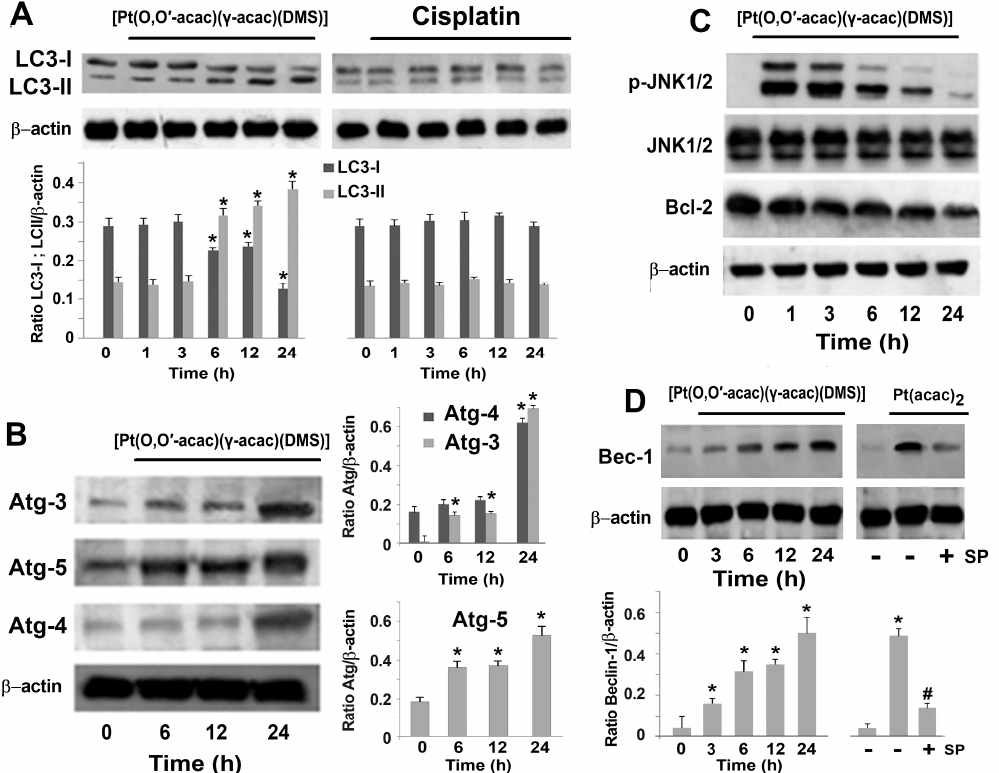
Figure 4. [Pt( O , O (cid:48) -acac)( γ -acac)(DMS)] induces autophagy in Caki-1 cells. ( A – C ) Caki-1 cells were treated with 10 µ M [Pt( O , O (cid:48) -acac)( γ -acac)(DMS)] or with 50 µ M cisplatin for different times. Cell lysates were analyzed by Western blotting using microtubule-associated proteins 1A/1B light chain 3B (LC3)I-II, autophagy-related (Atg)-3, Atg-4, Atg-5, JNK, and B-cell lymphoma 2 (Bcl-2) antibodies. Sequential incubation with anti- β -actin confirmed the equal protein loading. Representative immunoblots of three experiments are depicted. ( A , down) Densitometric analysis of LC3I-II normalized to β -actin. ( B , Right) Densitometric analysis of Atg-3, Atg-4, and Atg-5, normalized to β -actin. The data are means ± SD of three different experiments. * p < 0.001 between treated and untreated cells, by Student’s t -test ( n = 3). ( D ) (Up) Cells, were incubated with 10 µ M [Pt( O , O (cid:48) -acac)( γ -acac)(DMS)] for the indicated time or were pretreated with 10 µ M of JNK inhibitor SP600125 (SB) and then incubated with 10 µ M [Pt( O , O (cid:48) -acac)( γ -acac)(DMS)] (Pt(acaca) 2 ) , for 24 h. Cell lysates were analyzed by western blotting using monoclonal antibody specific to Beclin-1. Sequential incubation with anti- β -actin confirmed the equal protein loading. These figures are representative of five independent experiments. (Down) Densitometric analysis of Beclin-1 normalized to β